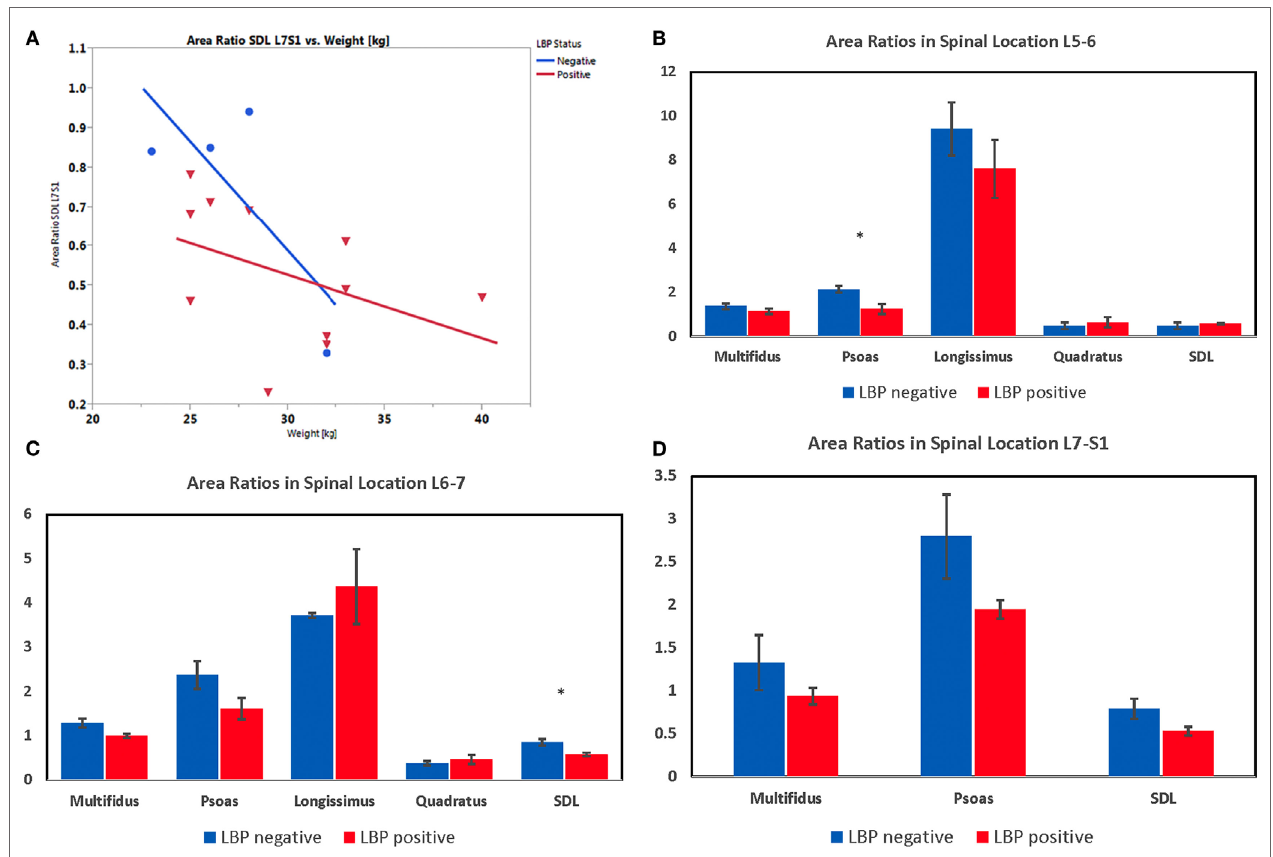
FIGURe 15 | (A) Plot representing the ANCOVA depicting the effect of lower back pain (LBP) and weight (covariate) on transverse area ratio of the sacrocaudalis dorsalis lateralis muscle at L7–S1 in Belgian malinois working dogs ( n = 15). One dog was excluded from these analyses, because the SDL was partially cut off in the scan field of view at L7–S1. Weight is a significant covariate ( p = 0.029), and there was no significant interaction of LBP and weight on transverse area ratio. (B) Transverse area ratios of muscles measured at the level of the disc space between the fifth and sixth lumbar vertebrae. (C) Transverse area ratios of muscles measured at the level of the disc space between the sixth and seventh lumbar vertebrae. (d) Transverse area ratios of muscles measured at the level of the disc space between the seventh lumbar and first sacral vertebrae. (*indicates significant at p < 0.05 for the particular spinal location detected by lower-tail t -test after Benjamini–Hochberg